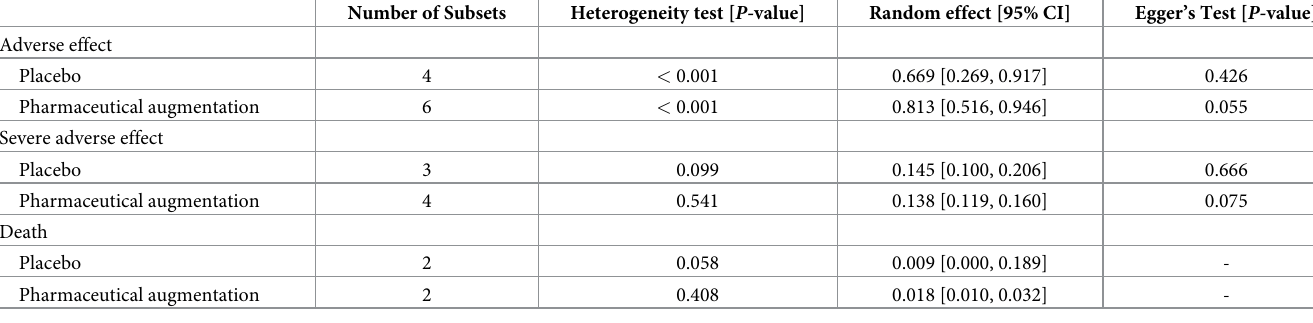
Table 4. The adverse effects according to the pharmaceutical